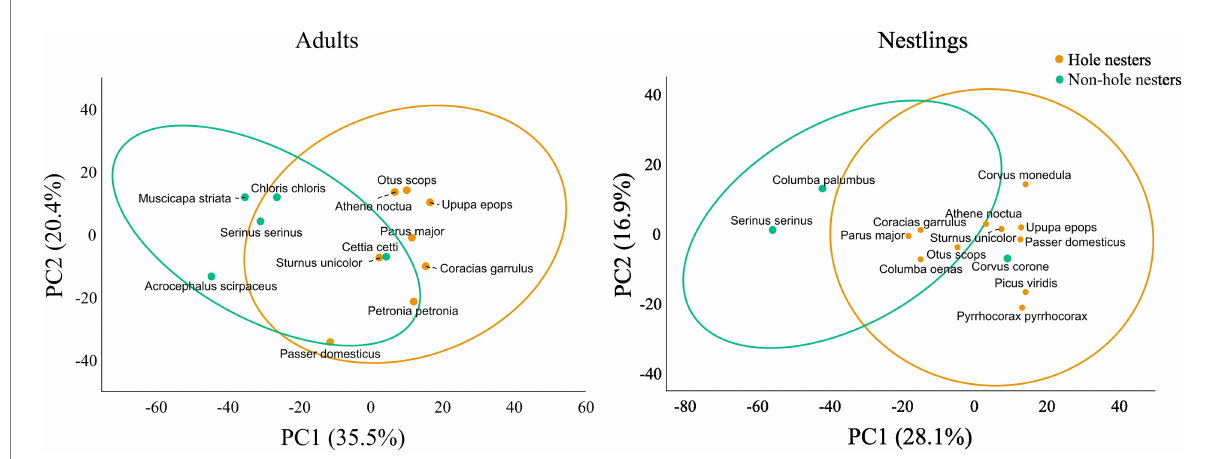
FIGURE 3 Principal Coordinates Analisis (PCoA) ordination plot using bray-curtis distances of the antimicrobial profile of bacterial communities isolated from the uropygial gland skin. Points are centroids per species and ellipses indicate 90% CI.